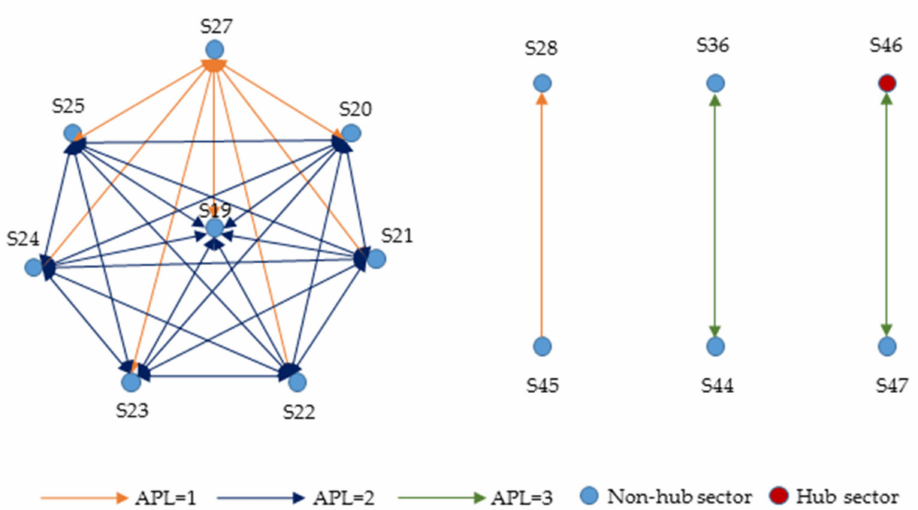
Figure 1. The hub wastewater propagation chains that APL-HCG selected in 2002. The orange, dark blue and green edges mean that their APL value is 1, 2 and 3, respectively. Each vertex in figures represents a sector, e.g., S47 in Figure 1 corresponds to Sewage Treatment explained in Appendix B. Dark red nodes indicate sectors that densely surround many linkages with a considerable degree of closeness to their linked sectors. The blue nodes imply that there are no surrounding dense linkages in the